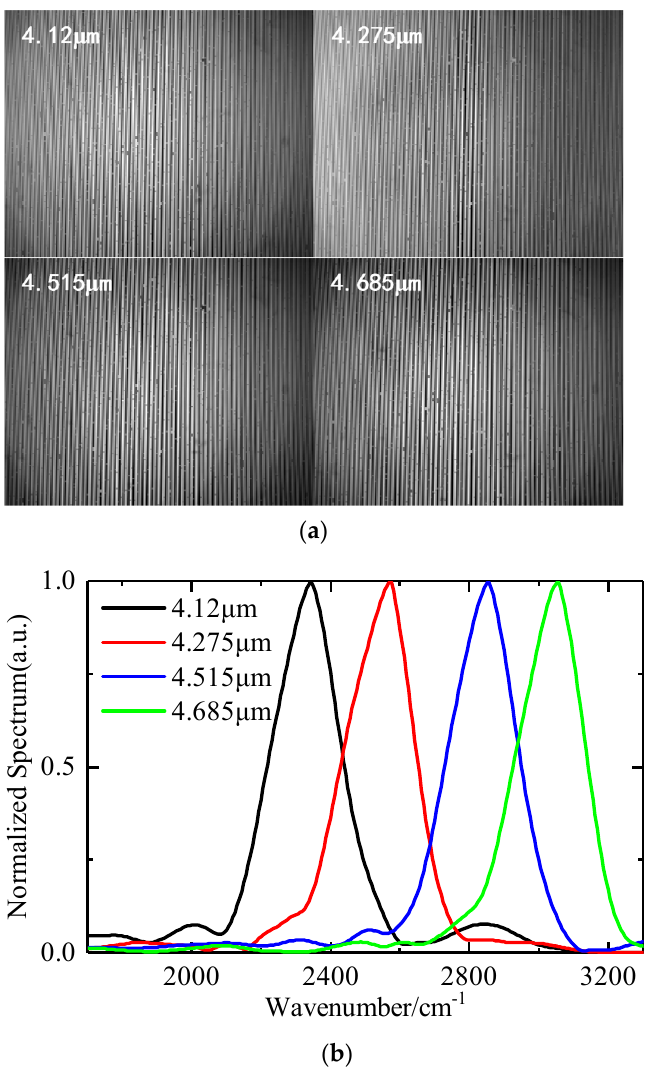
Figure 14. ( a ) Interferograms of filter set. ( b ) Normalized spectra of filter set.